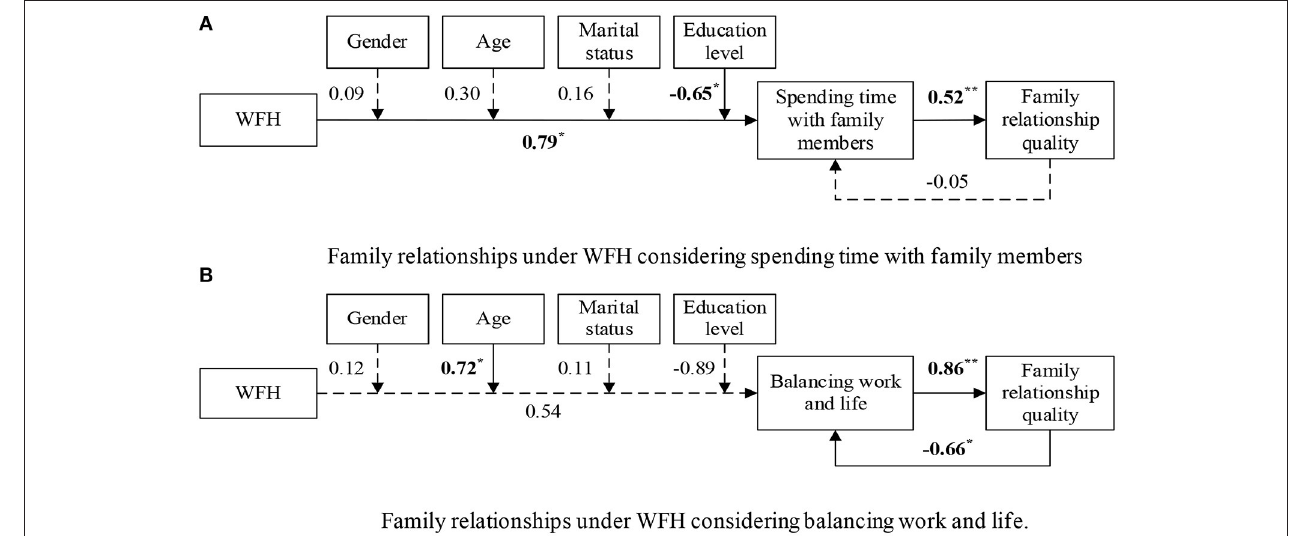
FIGURE 2 | Path models with standardized coefficients. (A) Family relationships under WFH considering spending time with family members. (B) Family relationships under WFH considering balancing work and life. Both figures were based on N = 150 participants and 263 responses. WFH was dummy coded (0 indicates before WFH, while 1 indicates during WFH). Gender was dummy coded (0 indicates women, while 1 indicates men). Marital status was dummy coded (0 indicates single, while 1 indicates married or lived together). Solid arrow lines indicated the statistically significant relations, while dotted arrow lines showed the relations that were not statistically significant. * p < 0.05. ** p <